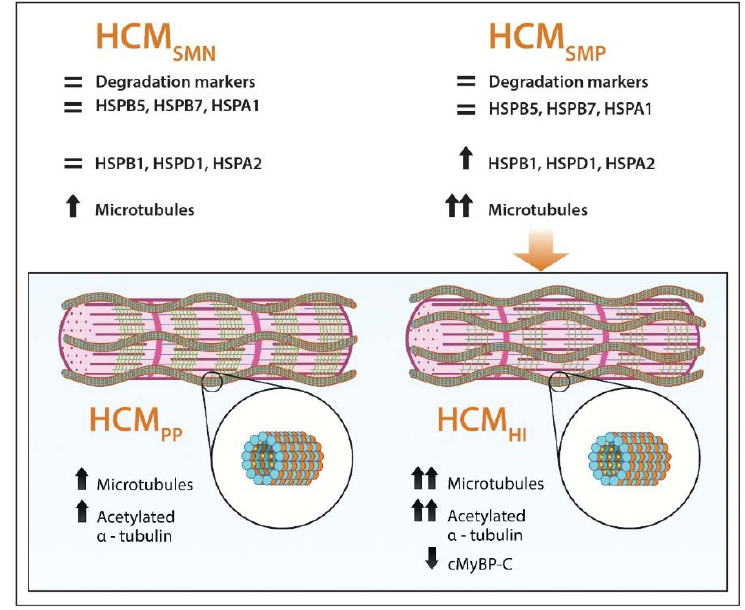
Figure 7. Schematic representation of PQC and microtubular system assessment in HCM. Our analyses show that HSPB1, HSPD1 HSPA2, α -tubulin and acetylated α -tubulin were increased in HCM, especially when a sarcomere mutation is present, while HSPB5, HSPB7, HSPA1 and degradation markers are not changed in HCM compared to controls. Levels of α -tubulin (orange balls) and acetylated α -tubulin (small yellow balls attached to α -tubulin in the lumen of polymerized microtubules (blue and orange balls)) were more increased when haploinsu ffi ciency (HI), characterized by lower levels of cardiac myosin-binding protein-C (green lines), was the underlying pathomechanism instead of poison polypeptides (PP). = : similar to controls; ↑ : significantly increased compared to controls; ↑↑ : highly significantly increased compared to controls; ↓ : significantly decreased compared to controls.